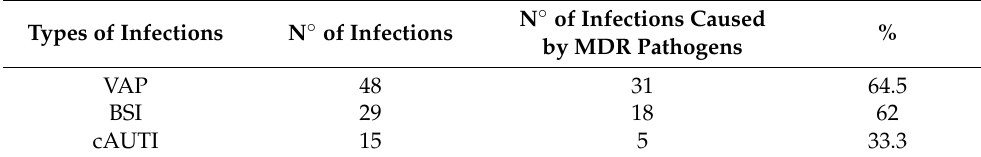
Table 1. Infections diagnosed during the study period.